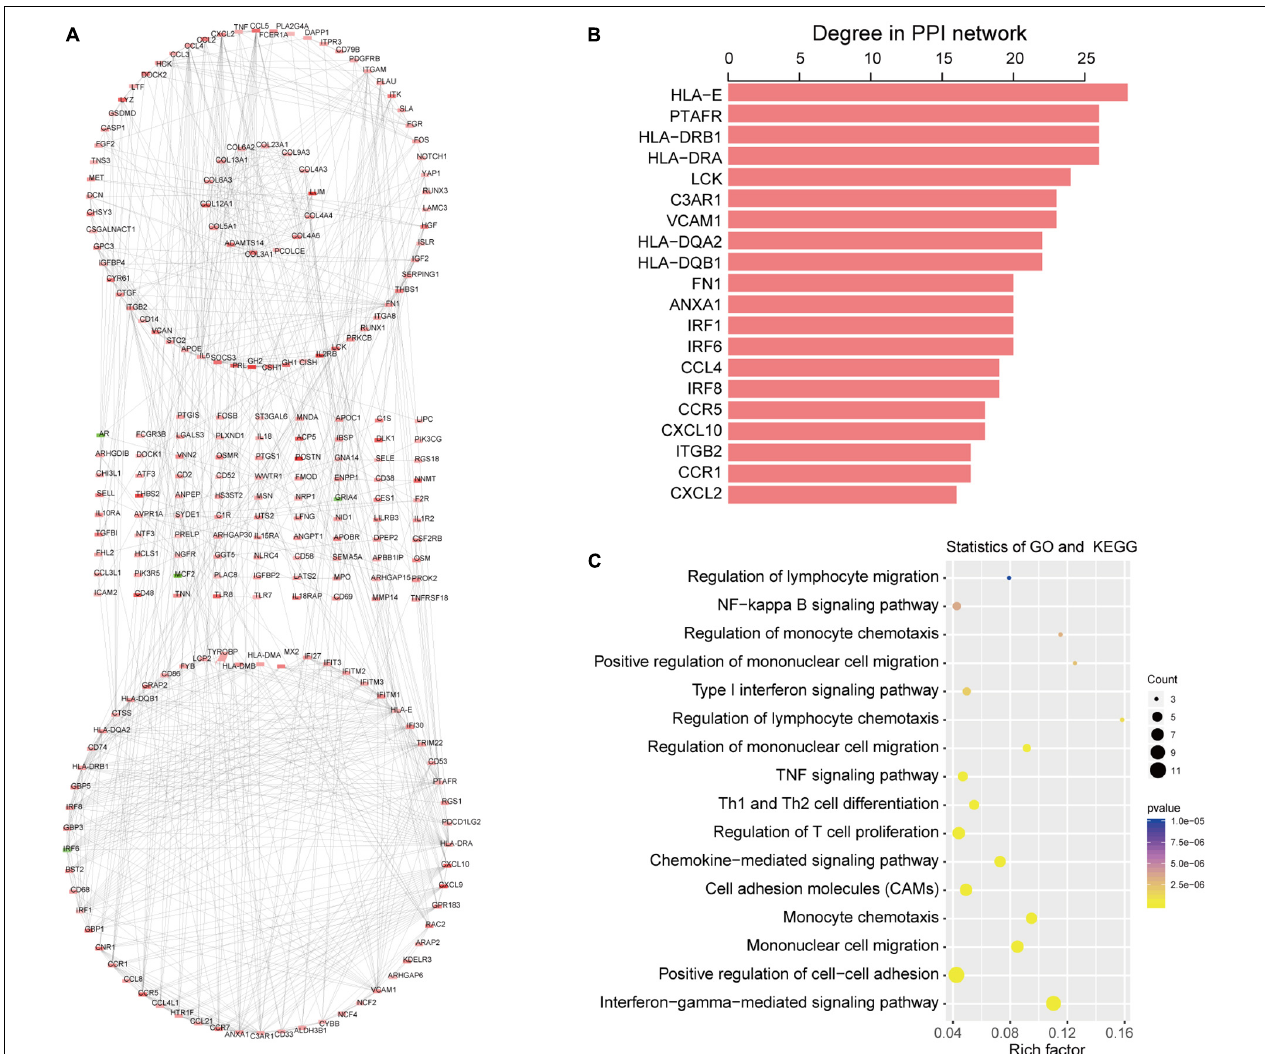
FIGURE 4 | Topological features of DEGs PPI network. (A) The view of the PPI network. Red indicates upregulation and green indicates downregulation. (B) The key DEGs in the PPI network with the top 20 degree distributions. (C) Function analysis of the 20 DEGs in the PPI